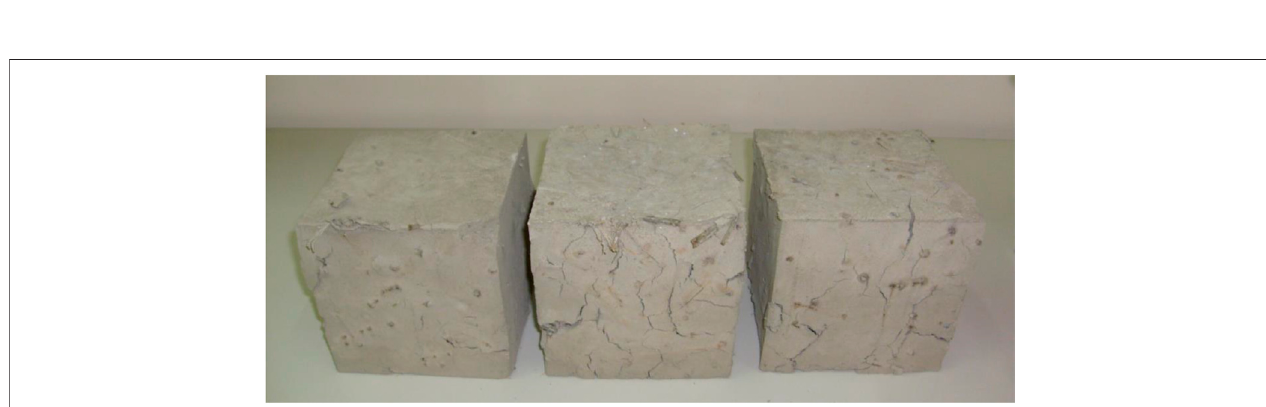
Frontiers in Built Environment |